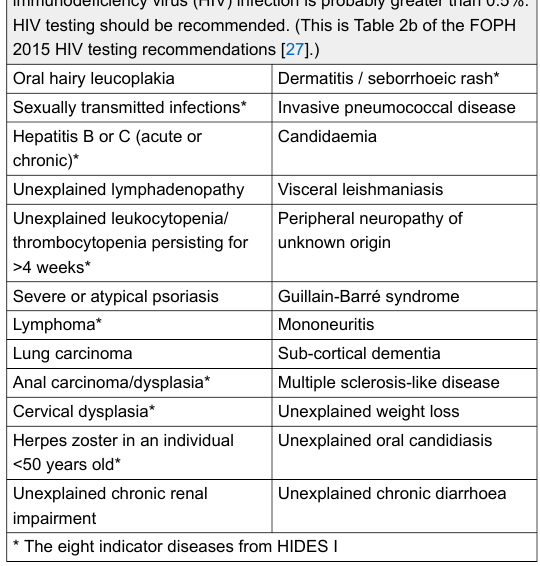
Table 1: Diseases in which the prevalence of undiagnosed human immunodeficiency virus (HIV) infection is probably greater than 0.5%: